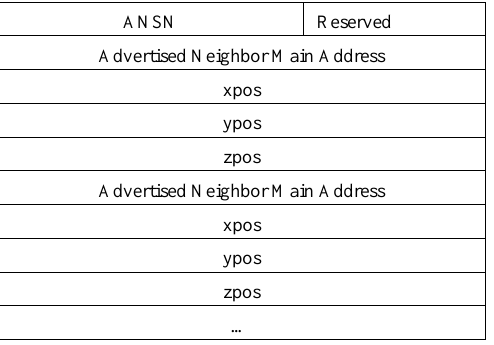
Table 5. The TC message with three-dimensional coordinates.